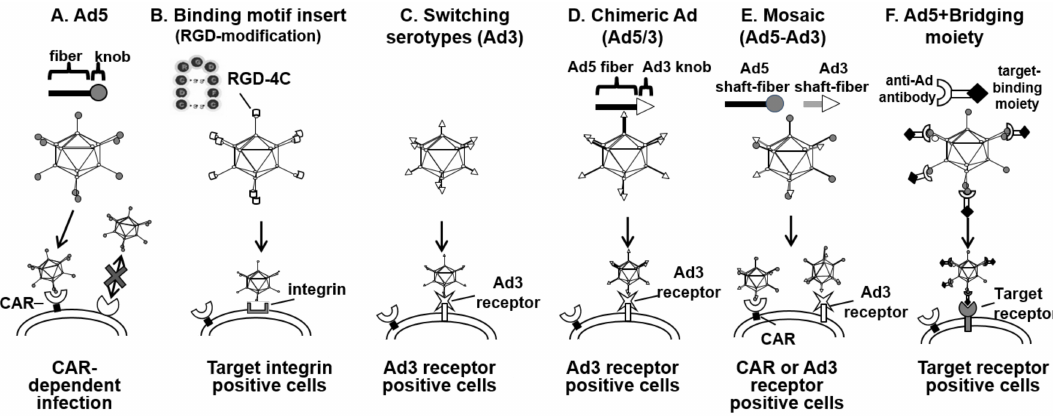
Figure 2. Modification of adenovirus to achieve Coxsackievirus and adenovirus receptor (CAR)-independent transduction. To achieve CAR-independent transduction, several modification strategies have been employed in adenovirus. ( A ) Poor infectivity of CAR-negative cells with conventional Ad system; ( B ) fiber modification; ( C ) switching serotypes; ( D ) chimeric; ( E ) mosaic; and ( F ) bridging molecule-based